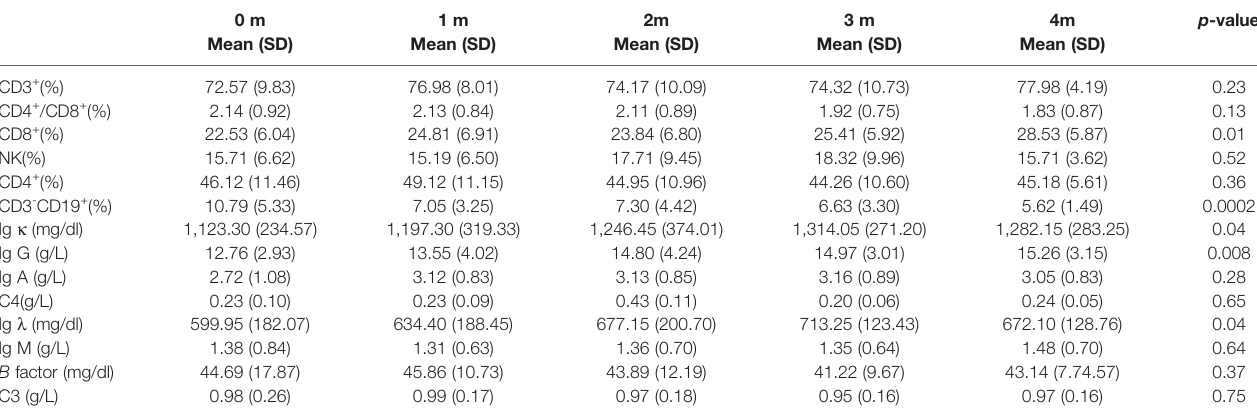
TABLE 4 | Percentage and number of biomarkers in peripheral blood.